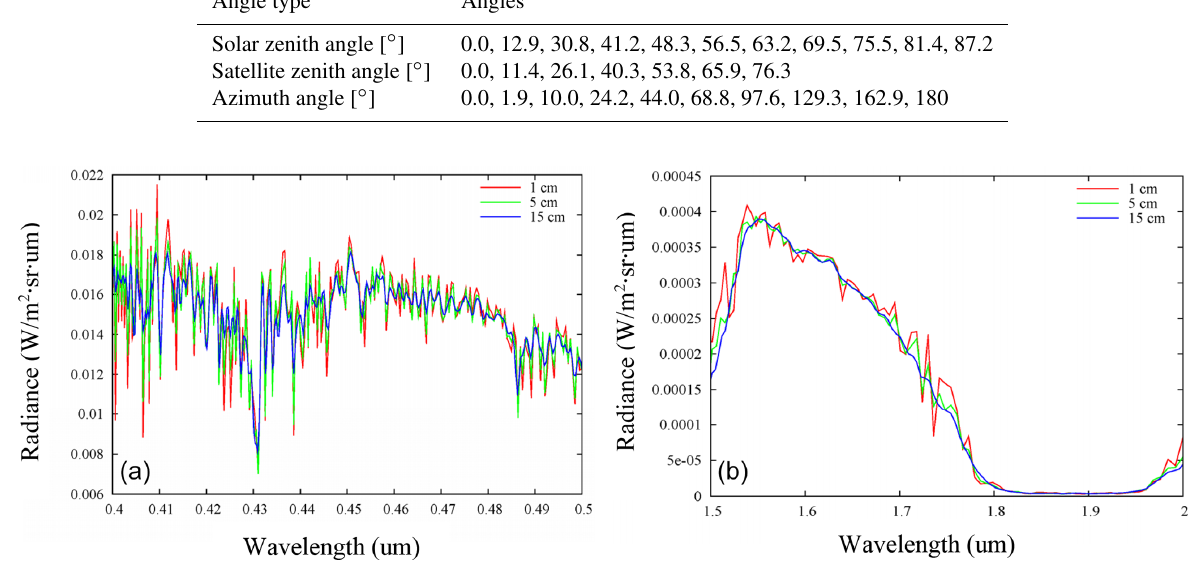
Figure 6. Simulated radiances from the DISORT eight-stream (with 1, 5, and 15cm − 1 resolution) band model for a spectral range of 0.4–0.5µm (a) and 1.5–2.0µm (b) .